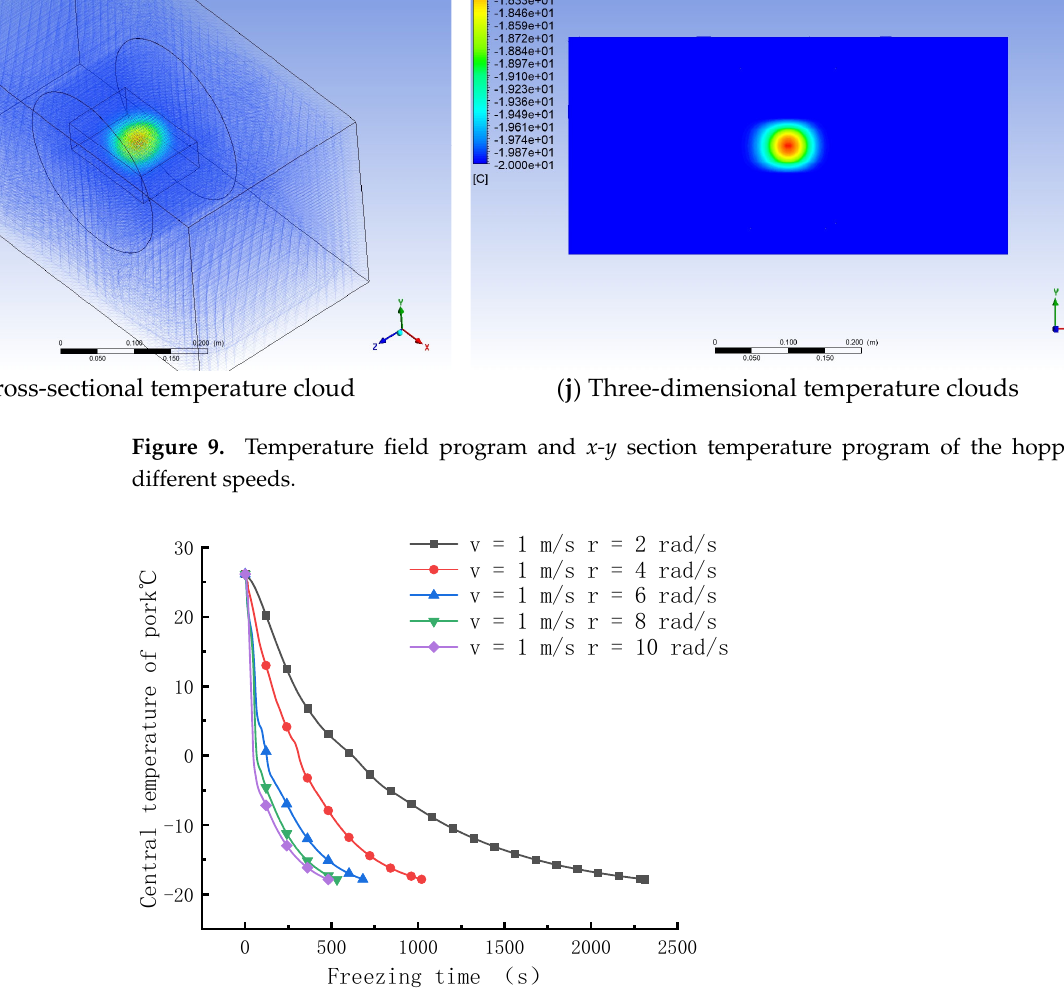
Figure 10. Change curve of pork center temperature and time with the increase of basket speed.